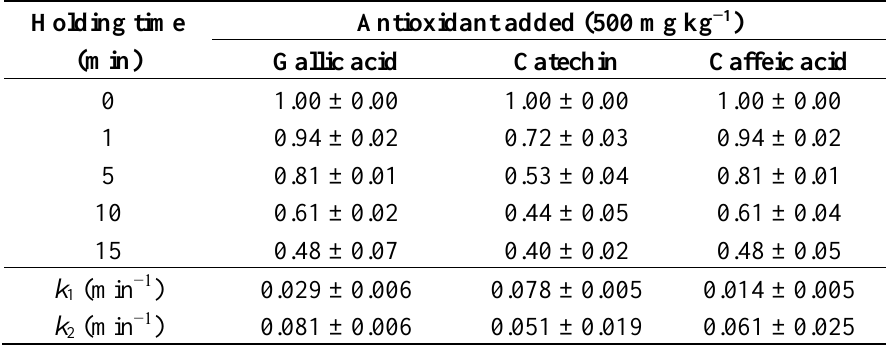
Table 4. Normalized phenolic content in CLA-enriched milk added with different phenolic antioxidants and treated at 120 °C and 600 MPa. Holding time Antioxidant added (500 mg kg −1 ) (min) Gallic